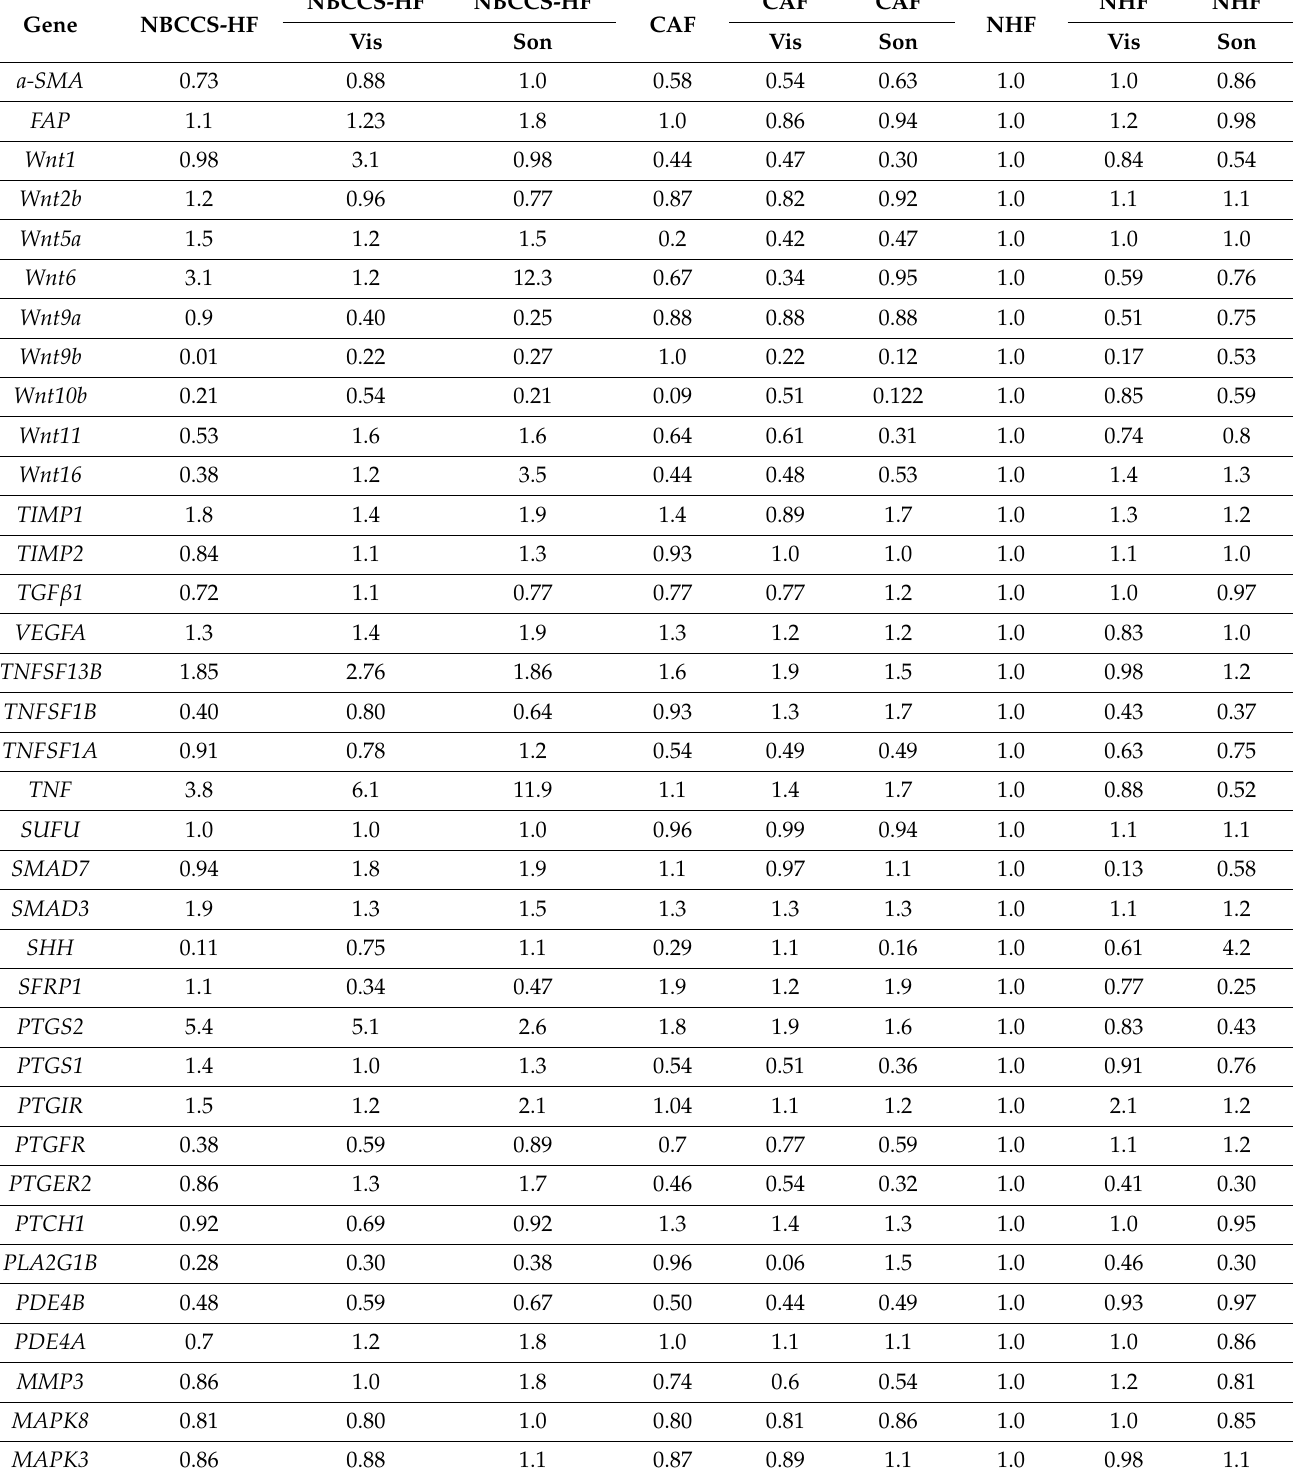
Table 3. Gene expression analysis, unmodified